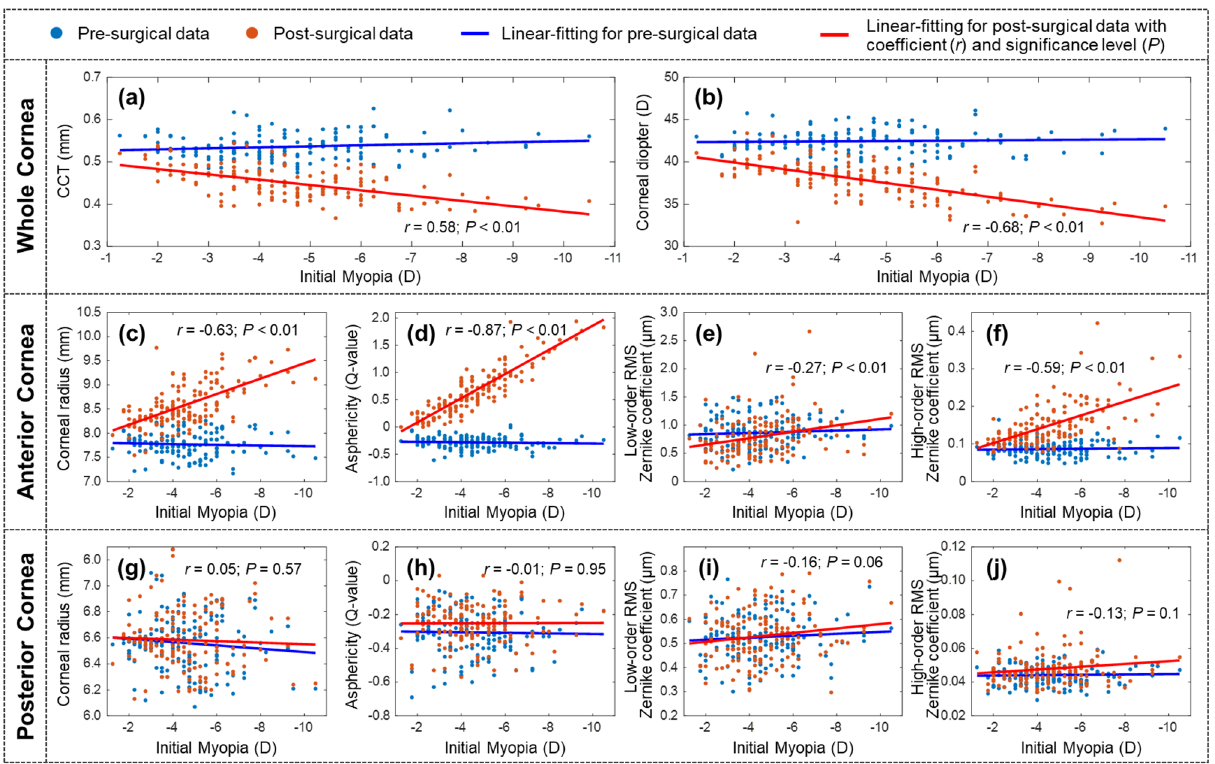
Figure 2. Comparison between the corneal parameters of 134 right eyes before and after the femto-LASIK surgery in response to the initial myopia (− 1.25 to − 10.5 D). These parameters include: ( a ) corneal center thickness (CCT); ( b ) corneal diopter; ( c ) and ( g ) anterior and posterior corneal radii; ( d ) and ( h ) anterior and posterior corneal asphericities (Q-values); ( e ) and ( i ) anterior and posterior corneal low-order (0–2) RMS values in Zernike terms; ( f ) and ( j ) anterior and posterior corneal high-order (3–6) RMS values in Zernike